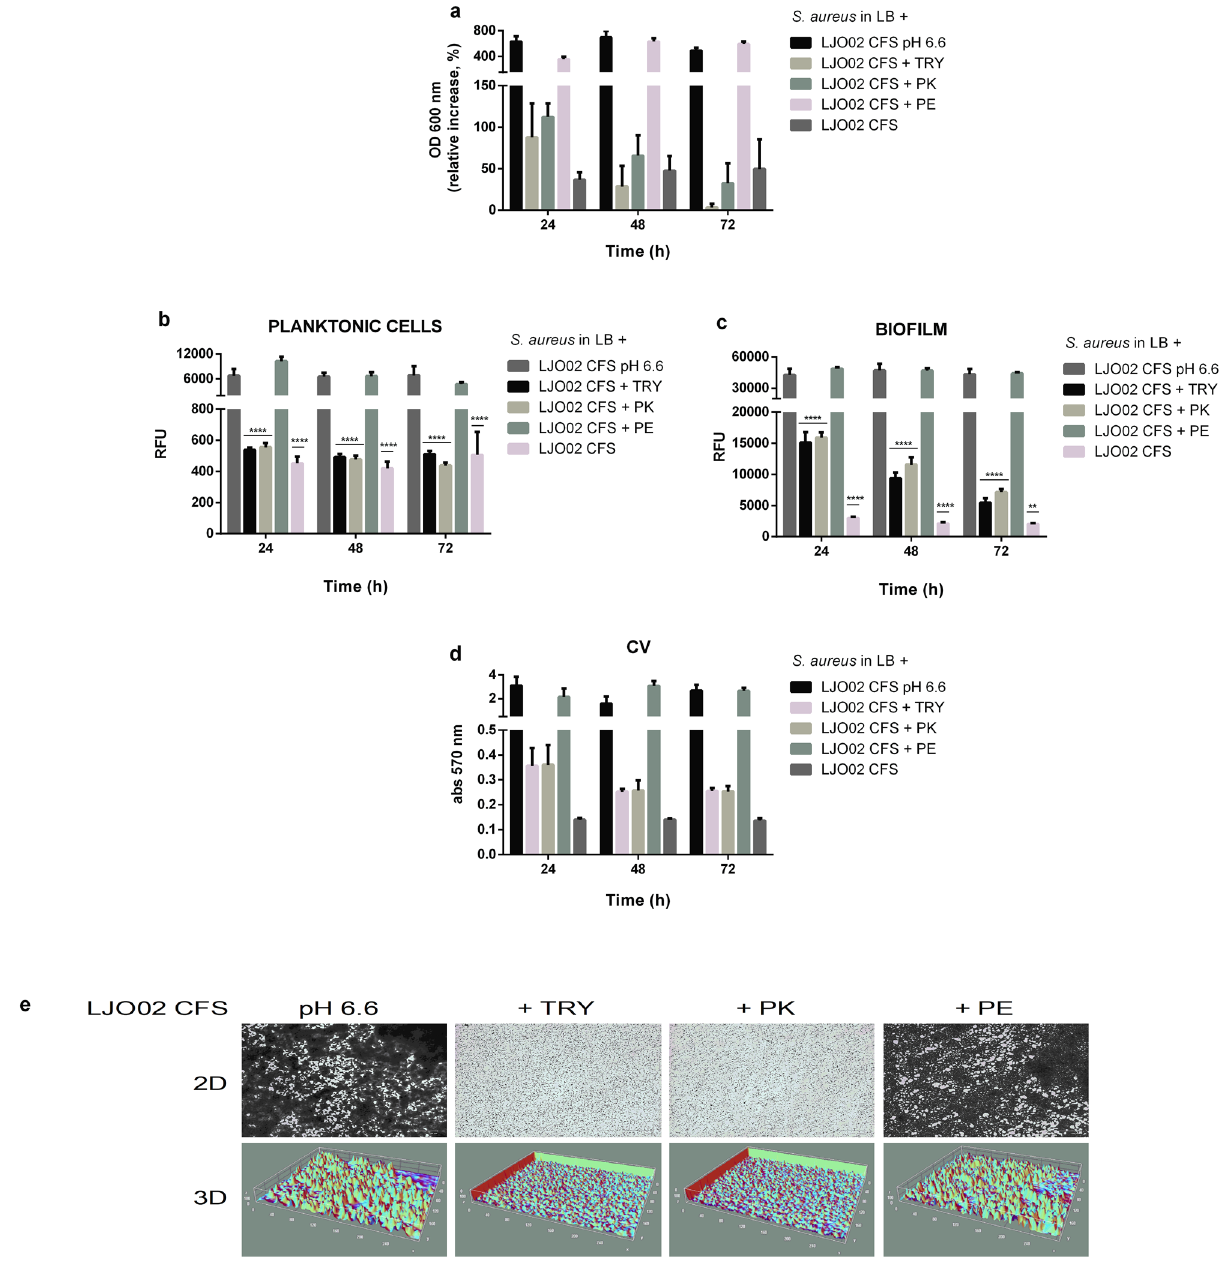
Figure 4. Evaluation of the effect of modified CFSs from LJO02 produced in TIL on S. aureus growth and biofilm formation. ( a ) S. aureus planktonic cell and biofilm OD 600 after 24, 48, and 72 h of incubation with the CFSs from LJO02 in TIL at pH 6.6 or enzymatically-digested (considering T 0 = 100% viability in each experimental condition). OD = optical density. CFS = cell-free supernatant. TRY = trypsin; PK = proteinase K; PE = pepsin. ( b ) Planktonic cell and ( c ) biofilm S. aureus viability assessment after 24, 48, and 72 h of incubation with modified CFSs. Data are expressed as mean ± SD of 3 independent experiments (n = 4). Trypsin and proteinase K-treated CFSs significantly reduce the planktonic cell viability compared to basification and pepsin treatment, similarly to what occurs with the untreated CFS ( p < 0.0001). Biofilm viability is significantly reduced by trypsin and proteinase K-treated CFSs with respect to basification and pepsin at all tested times ( p < 0.0001), but undigested CFS still shows the best performance ( p < 0.0001 at 24 and 48 h, and p < 0.01 at 72 h with respect to trypsin and proteinase K-digested CFS). Two-way ANOVA was applied with Tukey’s comparison test. ** p < 0.01, **** p < 0.0001. RFU = relative fluorescence units. ( d ) CV-reading at 570 nm of S. aureus biofilm at the 3 tested time points. ( e ) Representative 2D and 3D images of CV-stained S. aureus biofilm after 72 h of treatment with the modified CFSs. 2D pictures magnification: 460 X. Scale bar: 100